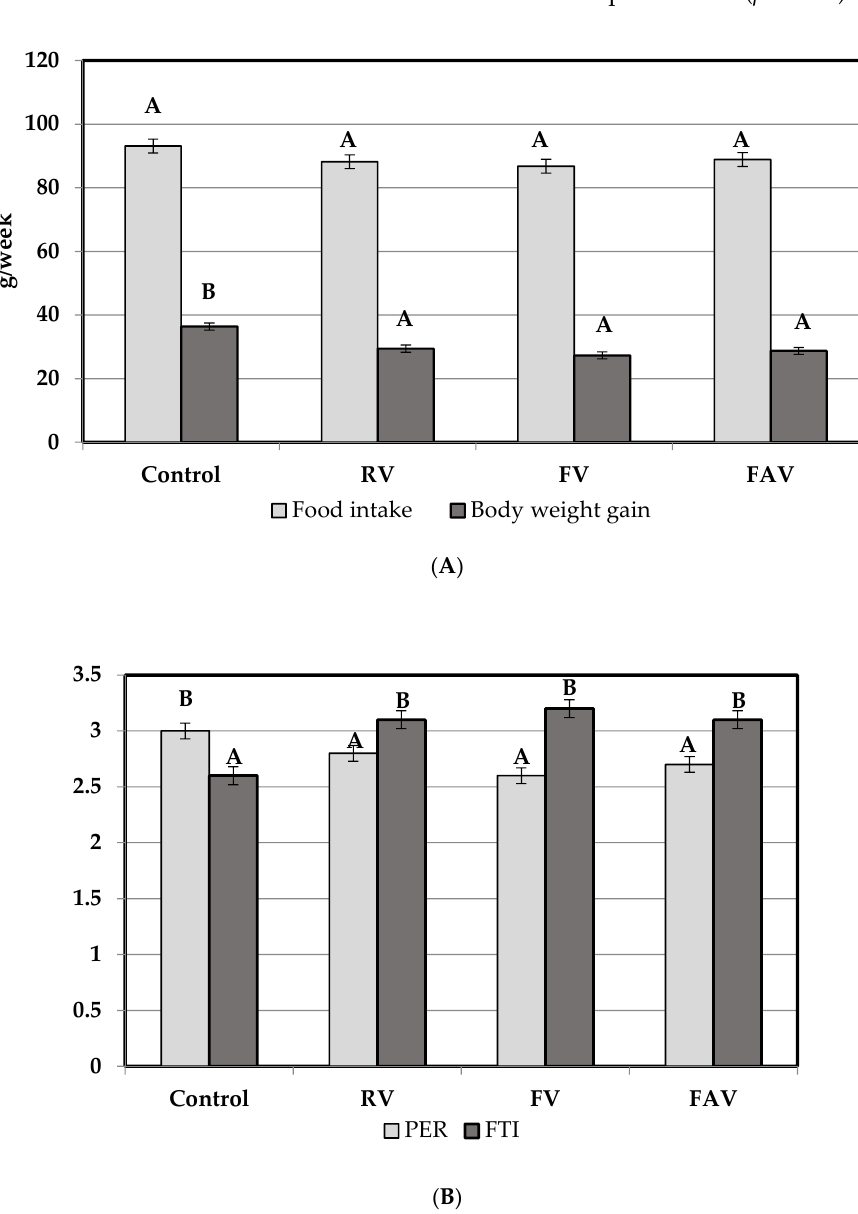
Figure 2. Effects of raw and fermented Vigna unguiculata on food intake and growth parameters of rats. ( A ) Food intake and body weight in the different experimental diets. Control: casein diet, RV: raw cowpea diet; FV: fermented cowpea diet; FAV: fermented and autoclaved cowpea diet. Different letters above columns indicate significant differences ( p < 0.05). ( B ) Growth parameters in the different experimental diets. Control: casein diet; RV: raw cowpea diet; FV: fermented cowpea diet; FAV: fermented and autoclaved cowpea diet. PER: Protein Efficiency Ratio (weight gain, grams per day/protein intake, grams per day); FTI: Food Transformation Index (total intake, grams dry matter per day/increase in body weight). Different letters above columns indicate significant differences ( p < 0.05).